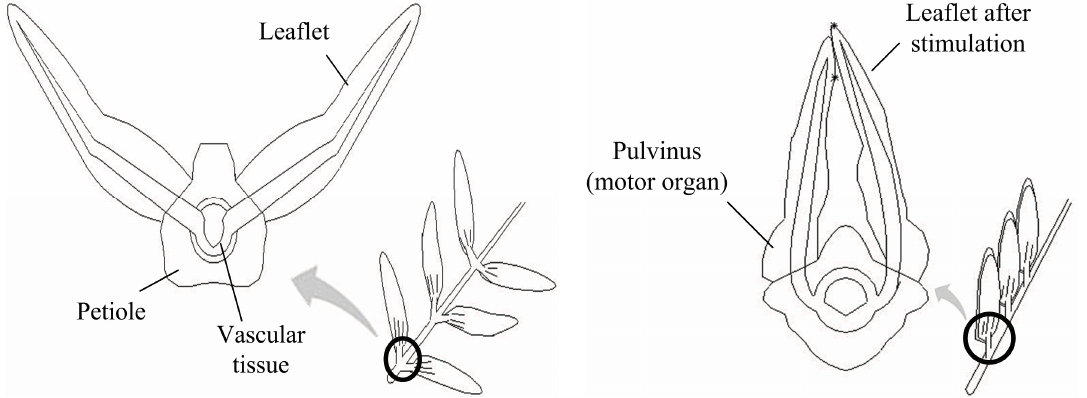
Figure 1. External structure of mimosa (the pinnate compound leaf open ( left ) and close ( right